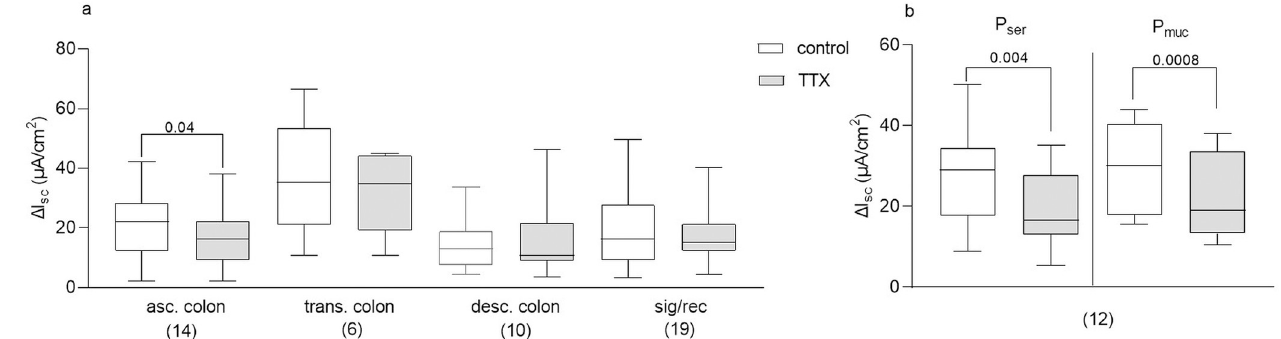
Fig 6. TTX sensitivity of the distension induced secretory response. Incubation of tissues with TTX prior to P ser (and P muc in porcine tissue) led to a reduced secretion only in the human ascending colon (a), and to a significant reduction in the secretory response in the porcine colon (b). Paired t test and Wilcoxon test; p values above brackets. Data shown are the medians with the 25 th and 75 th quartiles as a box plot and the minima and maxima as a whisker plot. N numbers are given in parenthesis.